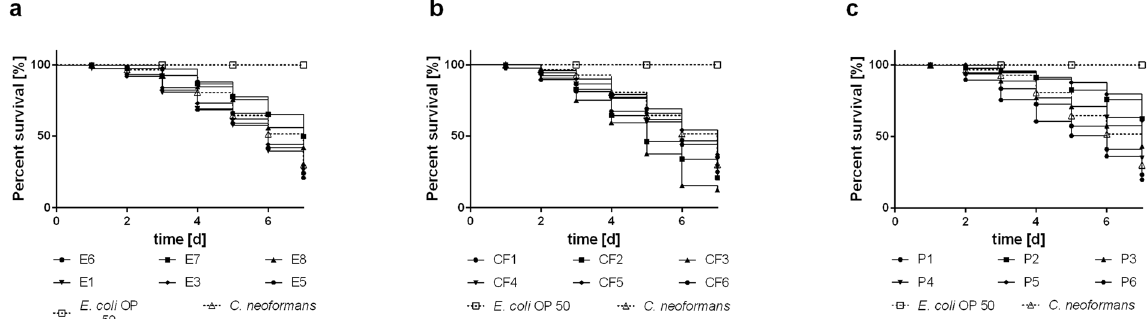
Figure 1. Survival of C. elegans after infection with E. dermatitidis strains from various sources. ( a ) Isolates from the environment (E); ( b ) Isolates from cystic fibrosis patients (CF); ( c ) Isolates from Asian patients (P). C. neoformans was used as an infection control; E. coli OP 50 was used as a non-infection control. E. dermatitidis exhibited pathogenicity in the C. elegans assay. Mortality rates varied between fungal strains. n = 30–40 individuals per test were used, every test was repeated 3